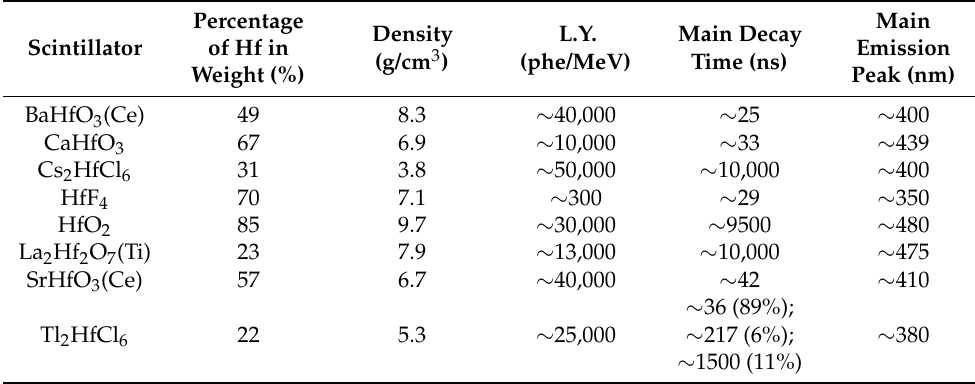
Table 4. Main properties of Hf-based crystal scintillators (See